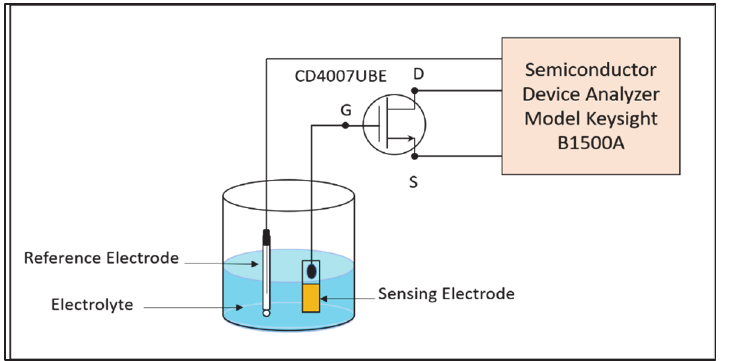
Figure 11. EGFET Measurement Setup.